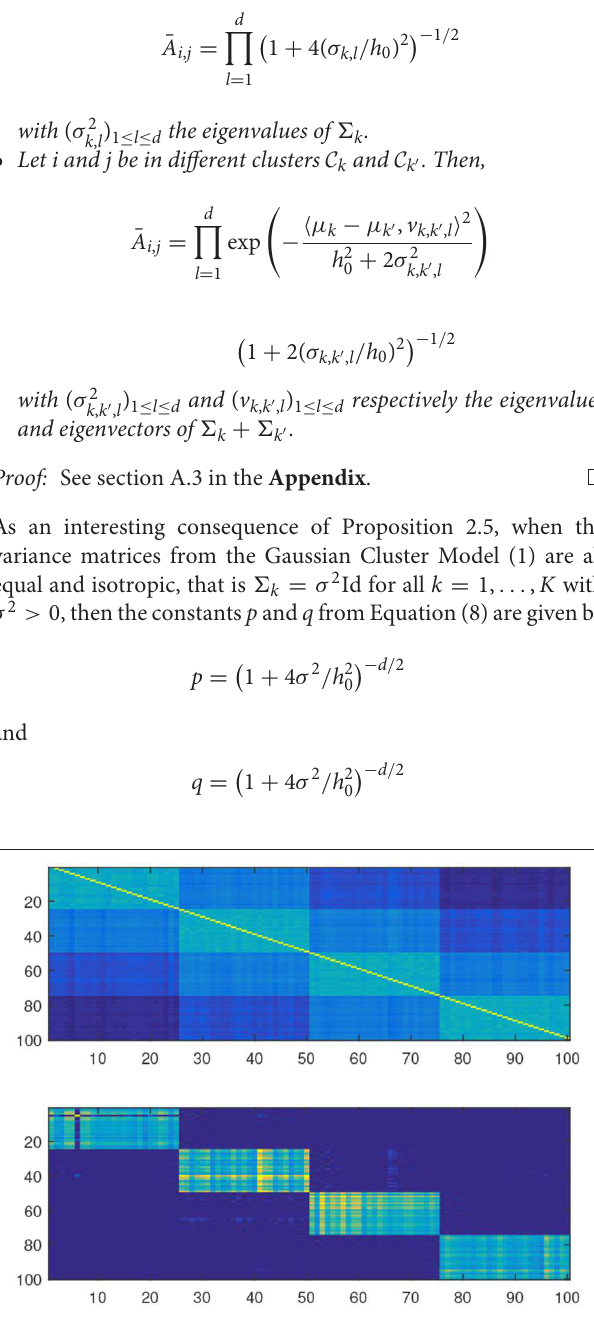
FIGURE 2 | Original affinity matrix vs. Guedon Vershynin Cluster